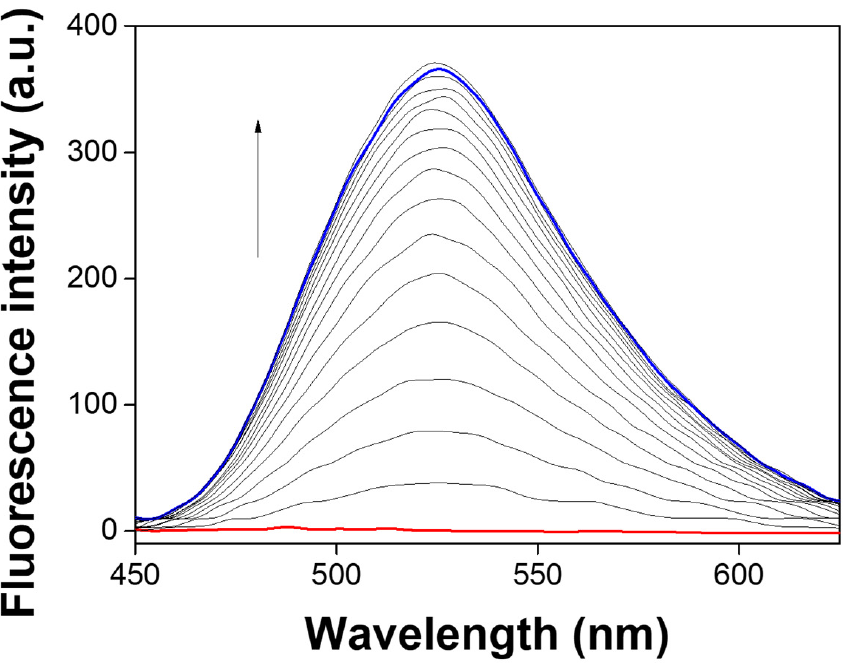
Figure 2. Fluorescence titration of NATB (30 μ M) with varied amounts of Al 3+ (0–1.5 equiv) in MeOH.